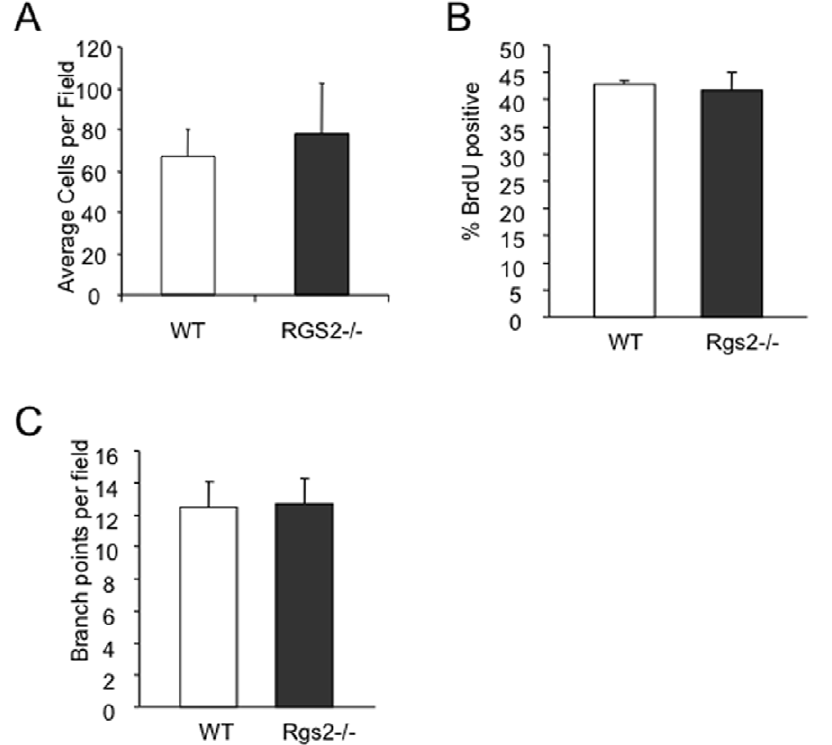
Figure 3. Lack of Rgs2 in endothelial cells does not affect migration, BrdU incorporation, or tube fomation. Lung microvascular endothelial cells were isolated from lungs of wild type and Rgs2 2 / 2 mice and cultured. (A) 1 6 10 5 cells were placed in the top chamber of a Transwell, and migrated to growth medium for 4 hours. Cells on the bottom of the Transwell (migrated cells) were fixed, stained with crystal violet, and counted. Experiment was performed 3 times in duplicate. (B) Cells were pulsed with 10 uM BrdU for 2 hours, then collected, processed, and analyzed by flow cytometry. The average percentages of BrdU positive cells was plotted. Experiment was performed 2 times in duplicate. (C) Cells were seeded on top of Matrigel in growth medium and allowed to form tube structures for 48 hours. Branch points were counted, and the average number per field was graphed.